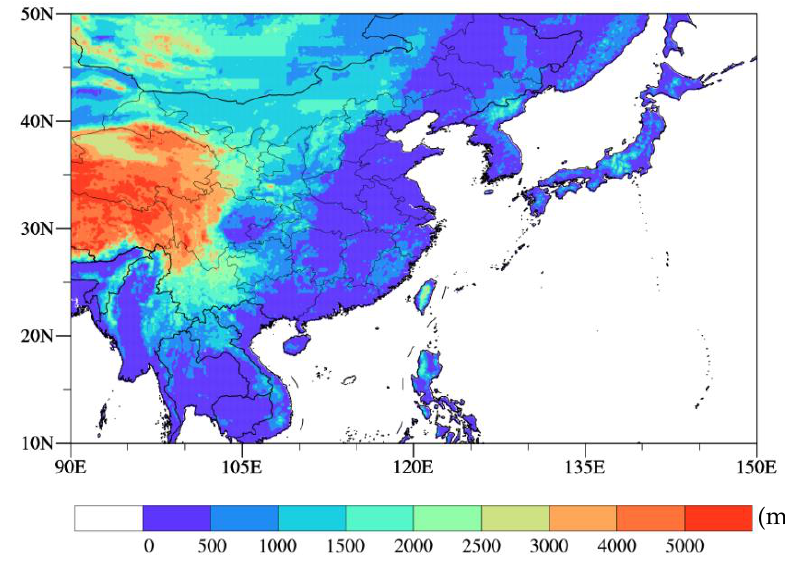
Figure 7. Spatial distributions of the topographic height in East Asia.